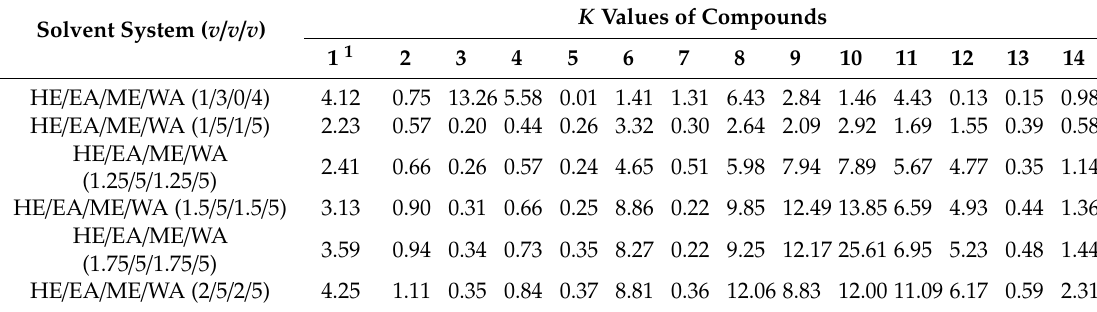
Figure 3. HPLC chromatograms of aldose reductase inhibitors (ARIs) isolated by HSCCC (a–d) and acid (a), procyanidin B3 (b), catechin (c), and methyl gallate (d).